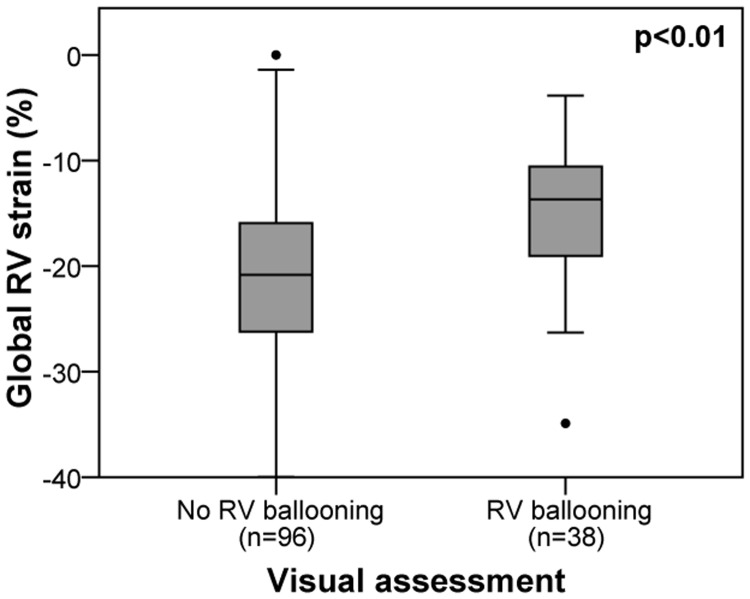
Global right ventricular strain in patients with and without right ventricular involvement according to visual assessment.Box (25th percentile, median, 75th percentile) and whisker (10th and 90th percentile) plots in TTS patients with and without RV ballooning according to sole visual assessment. RV = right ventricular.